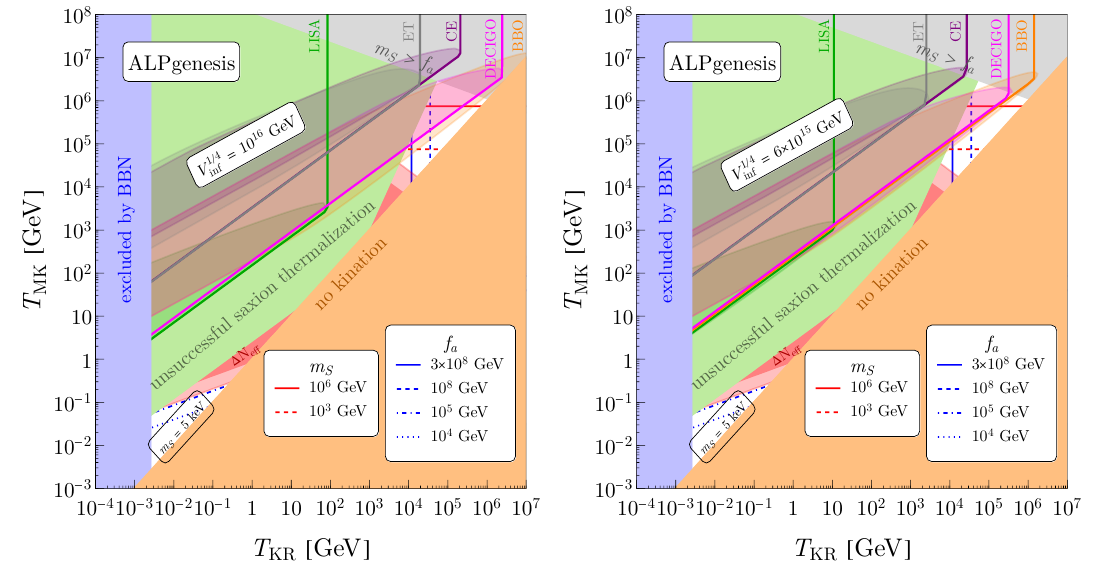
Figure 10 . Possible ranges of temperatures are shown for ALPgenesis assuming c B = 0 . 1 . Contours of required f a and m S are shown by the blue and red lines respectively. White and transparent regions are allowed. Thanks to a kination era, the primordial gravitational waves for V 1 / 4 (left panel) and 6 × 10 15 GeV (right panel) become detectable by the experiments specified next to the colored sensitivity curves. The transparent colored shading for each gravitational wave observatory indicates the regions where the peak in the gravitational wave spectrum falls within the experimental